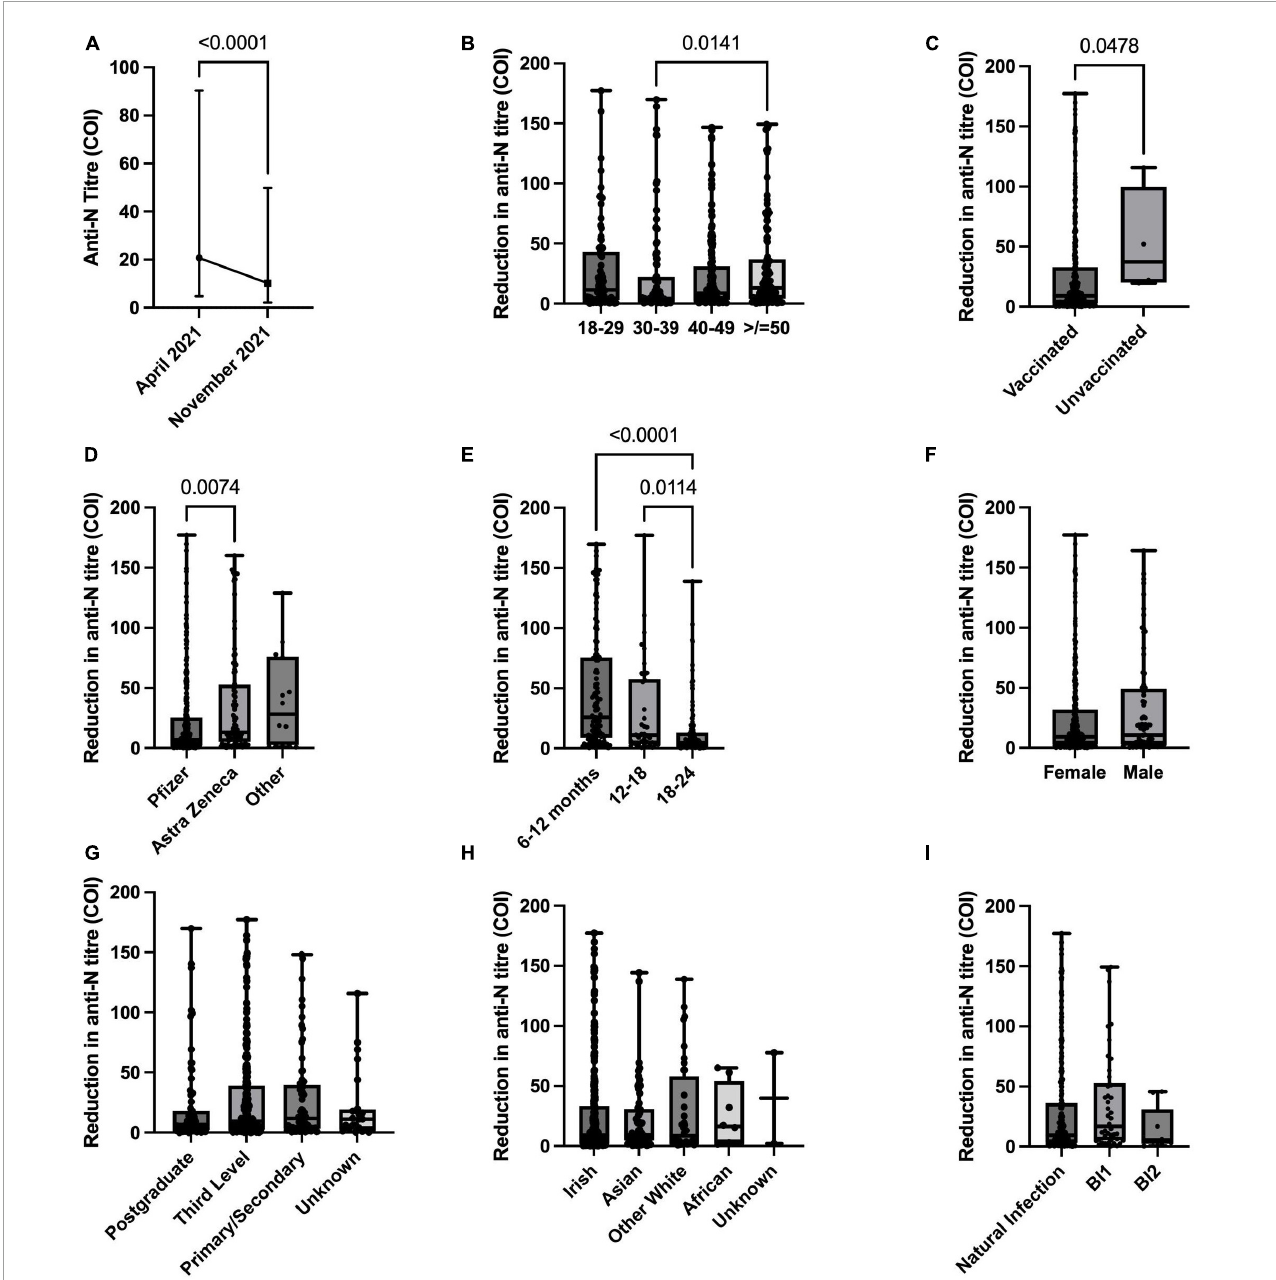
FIGURE1 Anti-nucleocapsid (anti-N) titre dynamics over time between April 2021 and November 2021. (A) Anti-N titre changes for paired sera cohort with positive anti-N in April 2021. B-I: Reduction in anti-N titres by (B) age group, (C) vaccination status, (D) COVID-19 vaccine received, (E) time from reported positive SARS-CoV-2 positive PCR to study serology sampling, (F) sex, (G) education level, (H) ethnicity, (I) infection status–natural (pre-vaccine), breakthrough following one vaccine dose (BI1), breakthrough following second vaccine dose (BI2).